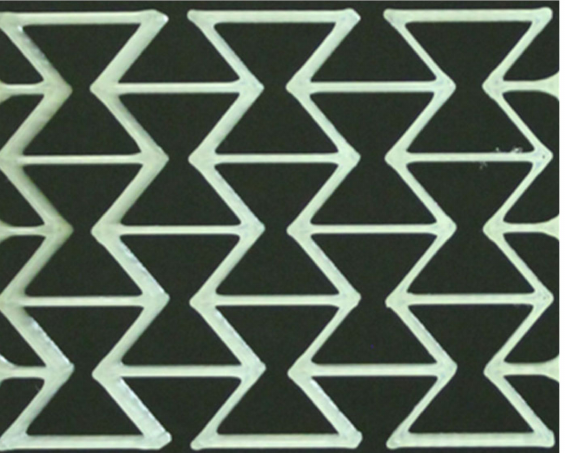
Figure 10. Auxetic structure with 3 × 3 honeycombs in longitudinal (horizontal) and transverse (vertical)